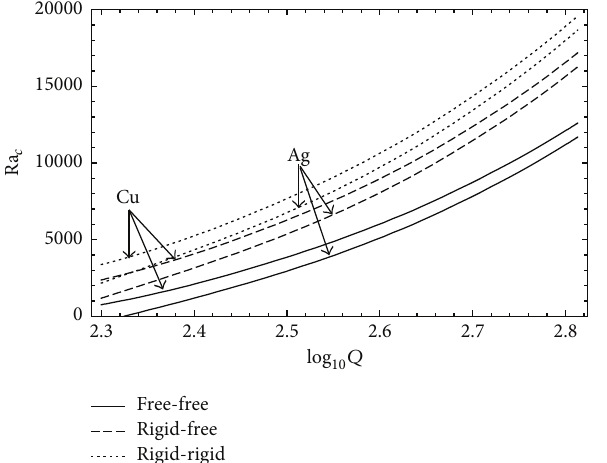
Figure 7: Plot of 𝛼 𝑐 with porosity for fixed Dr = 0.01 and 𝑄 = 250